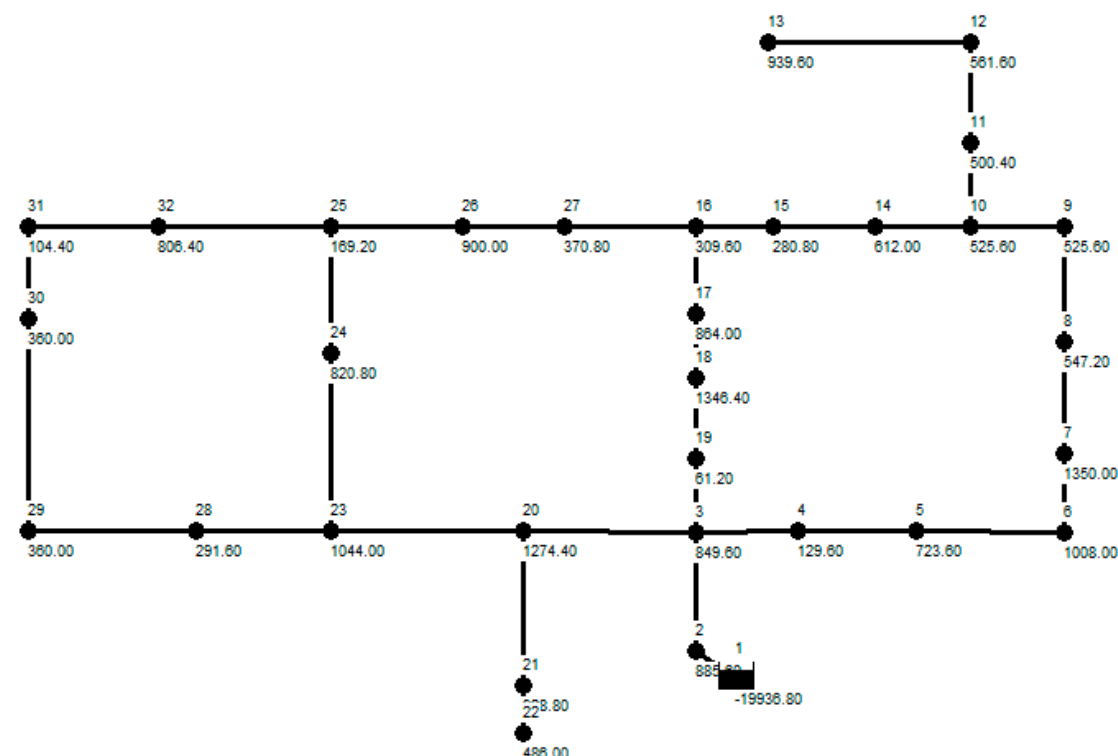
Figure 2. The layout of the Hanoi network (junction ID and water demand in m 3 / hour). Table 4. Factors applied in engineering benchmarks modified from the Hanoi network design problem.